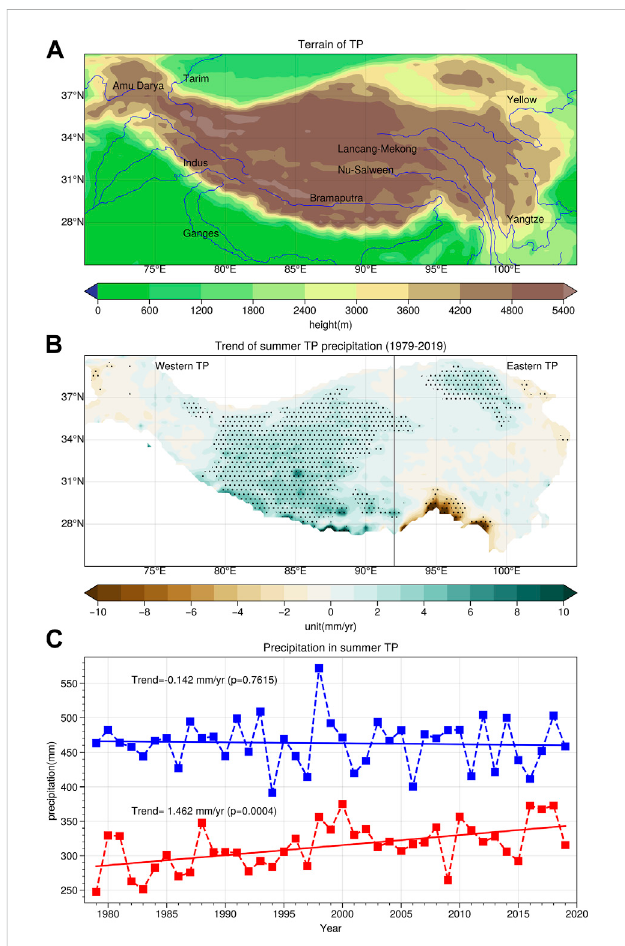
andtheterrainoftheTP.In (A) theterrainandmajorriversoftheTP.In (B) the trend map of total precipitation in summer (June to August) over the TP during 1979 – 2019. The dotted areas indicate statistical signi fi cance exceeding 95%. In (C) the time series of summer precipitation over the eastern TP (blue lines) and western TP (red lines), which are separated by 92 °